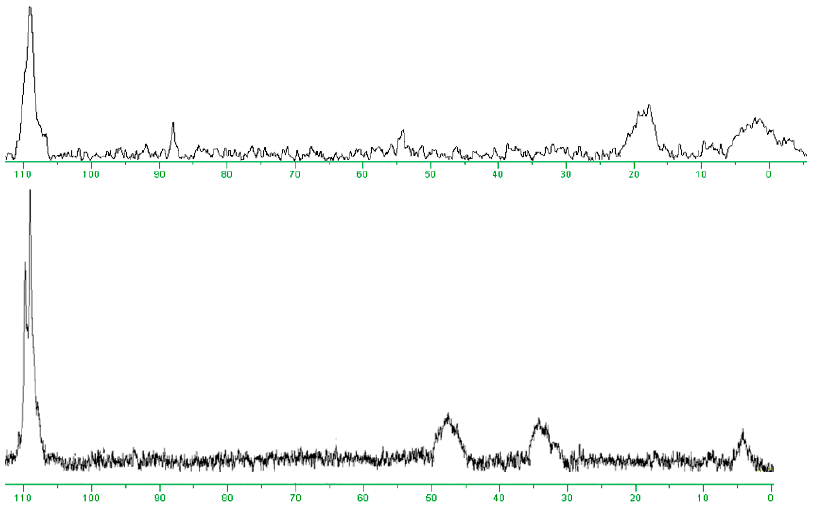
Figure 8. 19 F NMR spectra (300 MHz) of PFT-HSA ( top ) and PFX-HSA ( bottom ) conjugates in PBS at 37 °C.